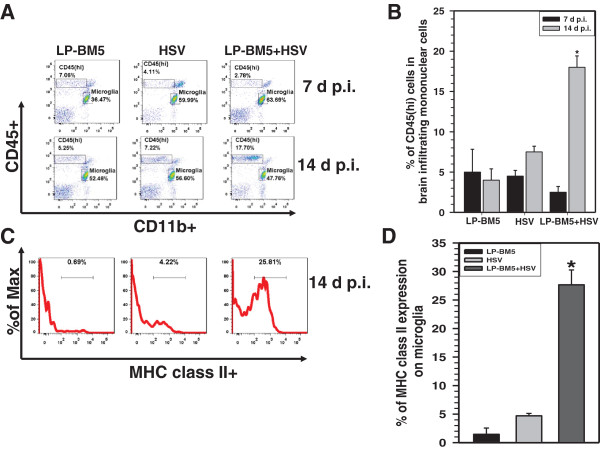
Dual infection triggered brain infiltration by peripheral immune cells and corresponding microglial cell activation. Single cell suspensions of brain tissue obtained from LP-BM5-, herpes simplex virus (HSV)- and LP-BM5 + HSV-infected mice (three to five animals per time point) were banded on a 70% Percoll cushion. Brain leukocytes were collected and labeled with PE-Cy5-conjugated Abs specific for CD45, AF700-labeled anti-CD11b, and allophycocyanin (APC)-labeled major histocompatability complex (MHC) class II. Analysis was done by using flow cytometry (FacsCanto, BD Biosciences, CA), with FlowJo software (TreeStar, Inc.). (A) The dot plots presented are representative of three experiments at 7 and 14 d post-infection (p.i.). The CD45hi population, representing peripheral immune cells, are clearly differentiated from the CD45int resident microglial cells. (B) The percentages of CD45hi cells among each group pooled from three independent flow cytometry experiments at 7 and 14 d p.i. with HSV are shown. (C) CD45intCD11b+ microglia were analyzed for upregulation of the activation marker MHC class II. Representative histograms from three independent experiments are shown. (D) The percentages of MHC class II expression on microglial cells at 14 d p.i. are shown. *P <0.01 versus HSV infection alone.